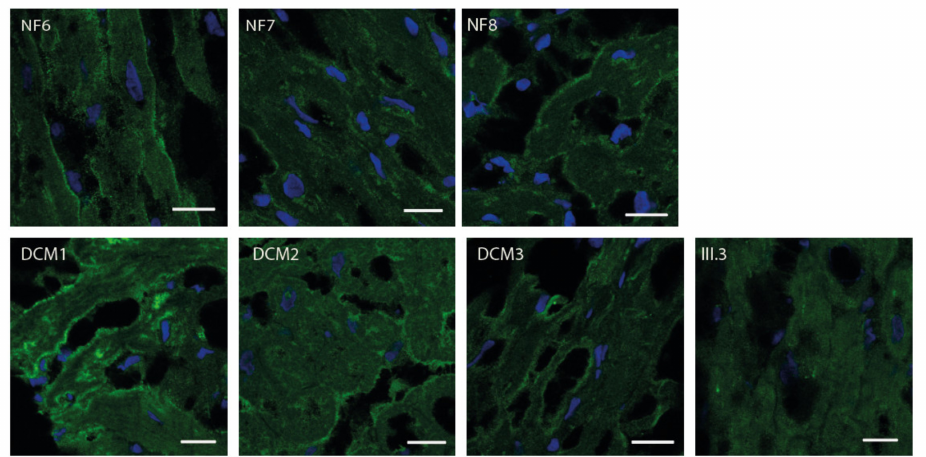
Figure 4. Immunofluorescence analysis of α -DG in the left ventricle. Left ventricular cryosections were labelled using an anti- α -DG primary antibody (clone VIA4-1) and an Alexa Fluor ® 488 con- jugated goat anti-mouse secondary antibody (green). Nuclei were stained with DAPI (blue). Scale bars = 20 µ m. DCM = samples from patients with dilated cardiomyopathy, NF = samples from rejected donor hearts, and III.3 = index patient (compare Figure 1). Samples from NF and DCM hearts showed a pronounced fluorescence signal around the cells. In III.3, only a weak and diffuse fluorescence signal was